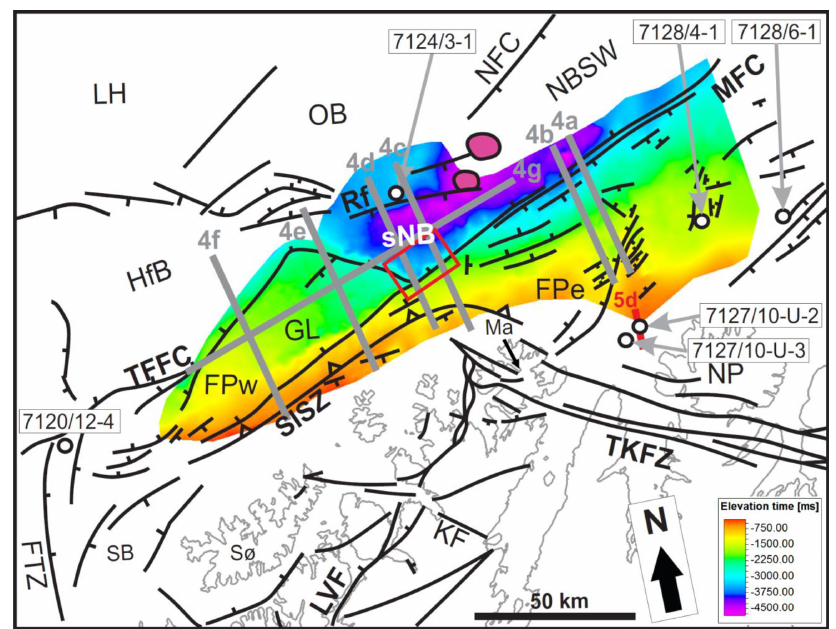
Figure 2. Regional structural map summarizing the architecture of the eastern (FPe) and western (FPw) Finnmark Platform and of the southwesternmost Nordkapp basin (sNB). The figure includes a time map of the interpreted mid-Carboniferous reflection. Grey lines show the location of seismic profiles displayed in Fig. 5a–g, the red line displays the location of the seismic section shown in Fig. 6d, and the red frame indicates the location of seismic Z slices described in Fig. 8. White dots show the location of exploration wells and shallow drill cores while purple blobs represent major salt diapirs in the southernmost part of the Nordkapp Basin (NBSW). See Fig. 1 for